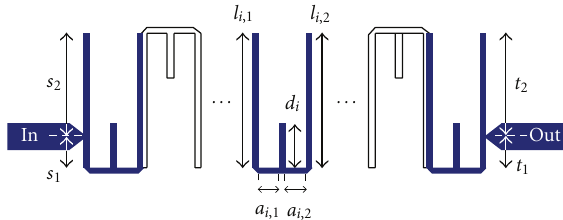
Figure 1: Schematic diagram of proposed multilayer microstrip hairpin